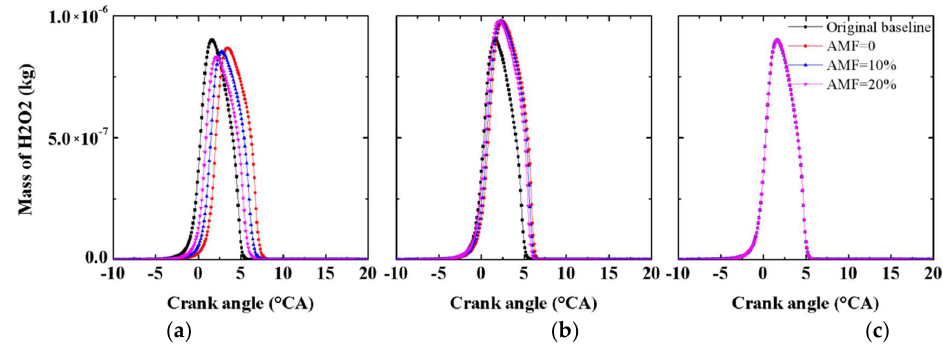
Figure 7. Mass of H 2 O 2 radicals at different DI timings with variation of AMF: ( a ) DI timing = −105 °CA; ( b ) DI timing = 0 °CA; ( c ) DI timing = 40 °CA. Energies 2019 , 12 , x FOR PEER REVIEW